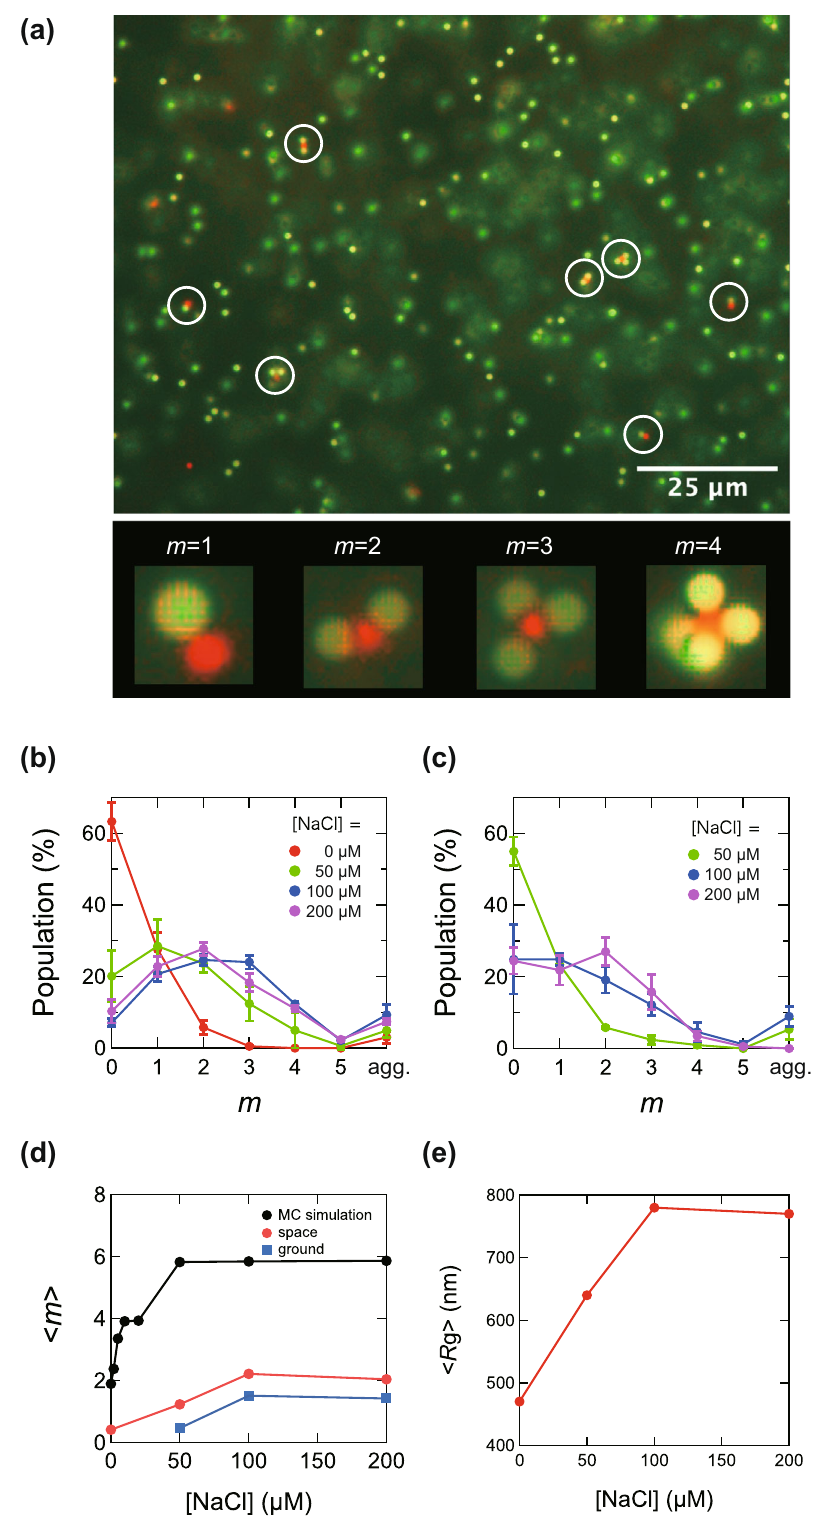
Fig. 4 Microscopic images of PS clusters and distribution of association number. a Fluorescence micrographs of polystyrene (PS) clusters from the space experiment and magni fi ed images of m = 1 to m = 4 clusters. b , c Distribution of the number of clusters m at various NaCl concentrations in the ( b ) space experiment and ( c ) ground experiment. d The plot of average cluster number < m > vs. [NaCl]. MC simulation results are also shown. e The plot of the average radius of inertia < R g > vs. [NaCl] for clusters obtained by neutron